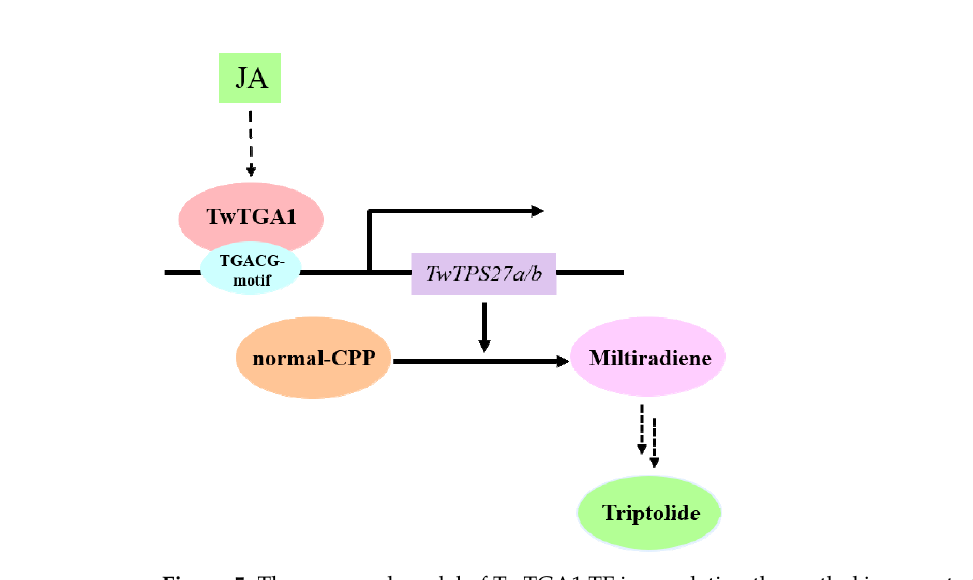
Figure 5. The proposed model of TwTGA1 TF in regulating the methyl jasmonate (MeJA)-mediated triptolide biosynthesis through the activation of TwTPS27a/b .